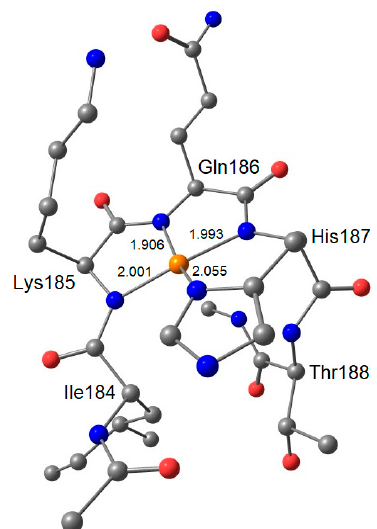
Figure 6. Optimized structure at the level of theory B3LYP-D3 of the adduct [Cu(H –2 L)] formed